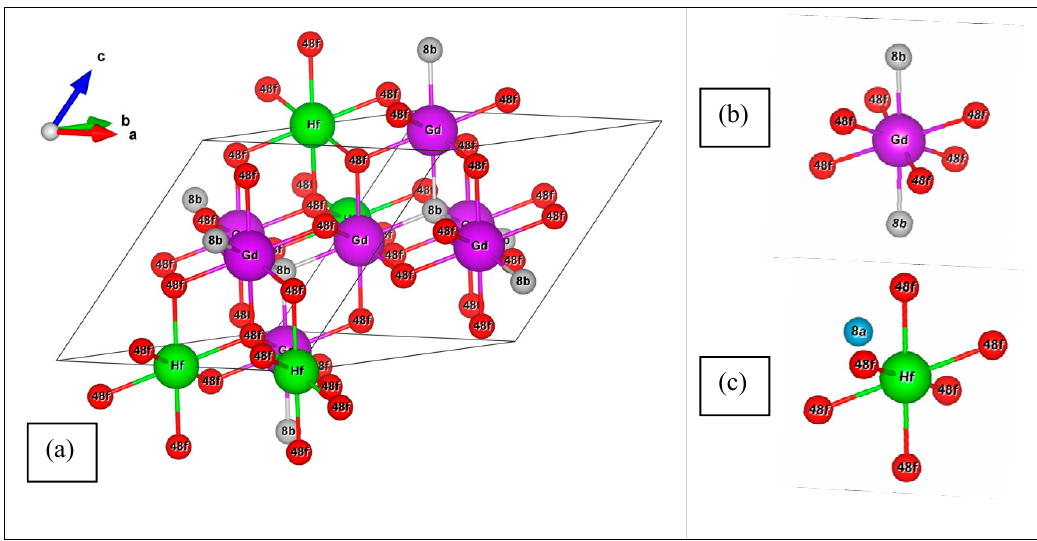
Figure 1. The OP-GHO structure ( a ) primitive cell. Lines show the unit cell boundaries. The O 48f and O 8b are shown by red and gray spheres, respectively. ( b , c ) show the OP-GHO Gd and Hf sites illustrating the O site and its vacancy (O 8a ; cyan sphere).